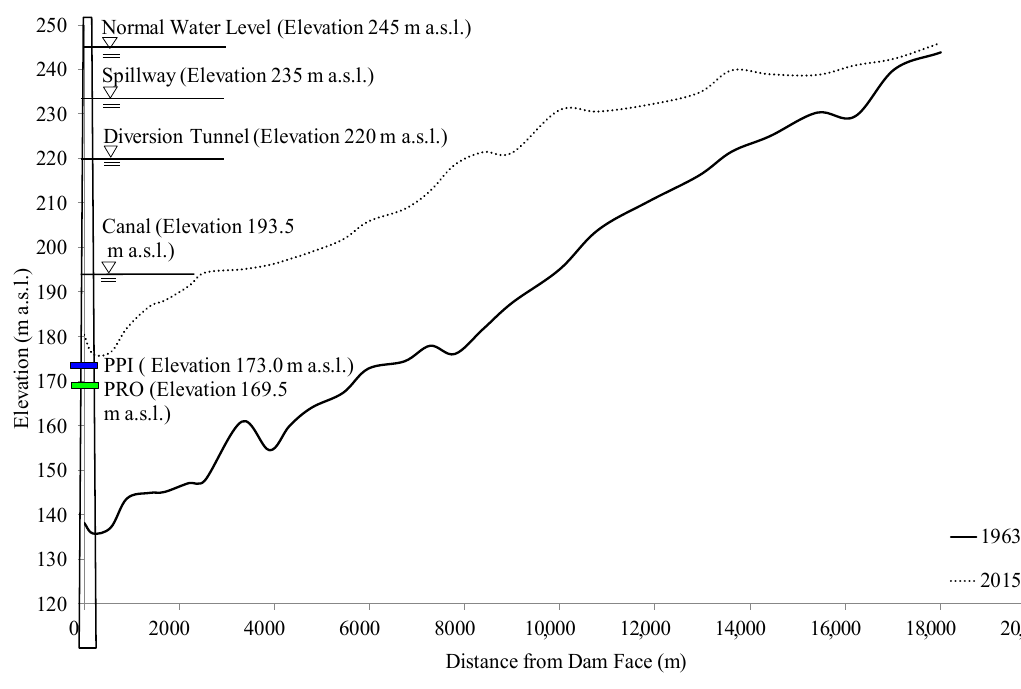
Table 1. Release e ffi ciency of bottom outlets during typhoons from 2015 to